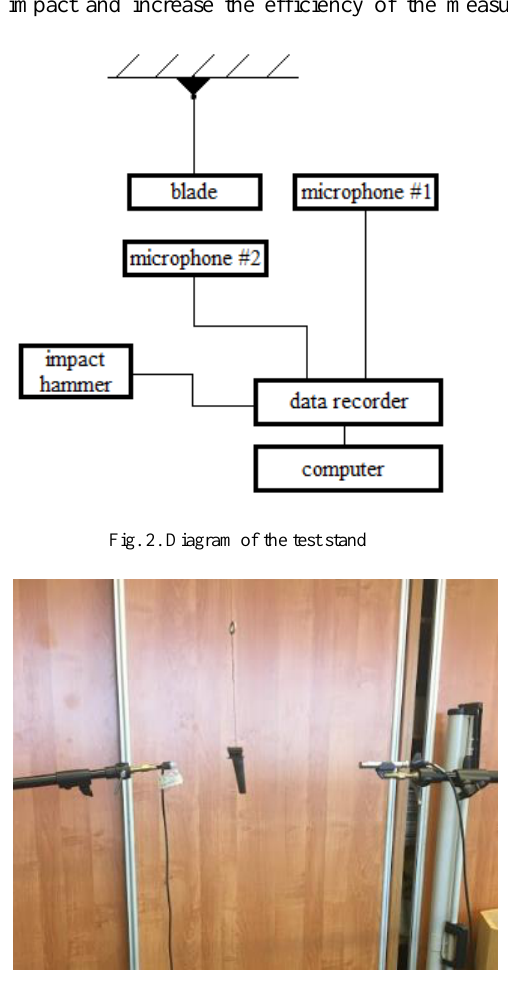
Fig. 3. Positioning of the microphones